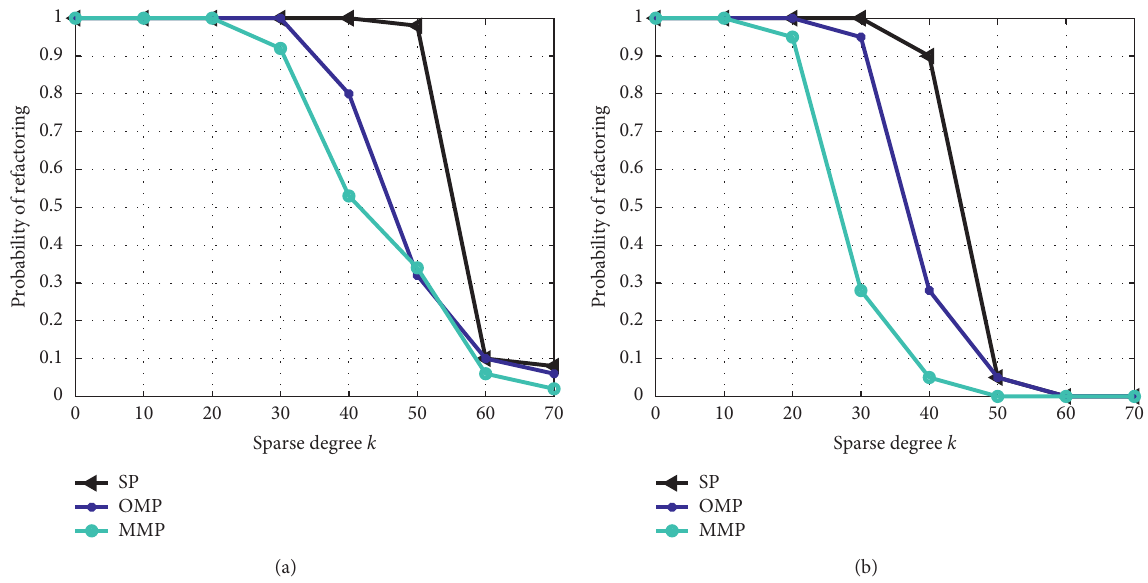
Figure 4: .Variation of reconstruction probability of different greedy reconstruction algorithms with sparsity K. (a) Gaussian signal. (b) 0-1 signal.